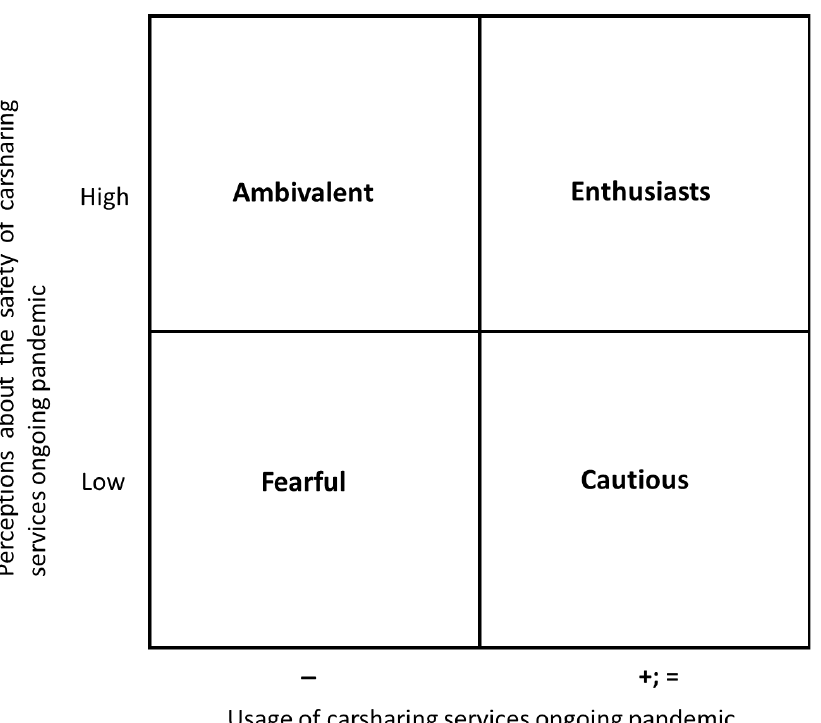
Figure 1. Matrix of emerging car sharing profiles in the ongoing pandemic.